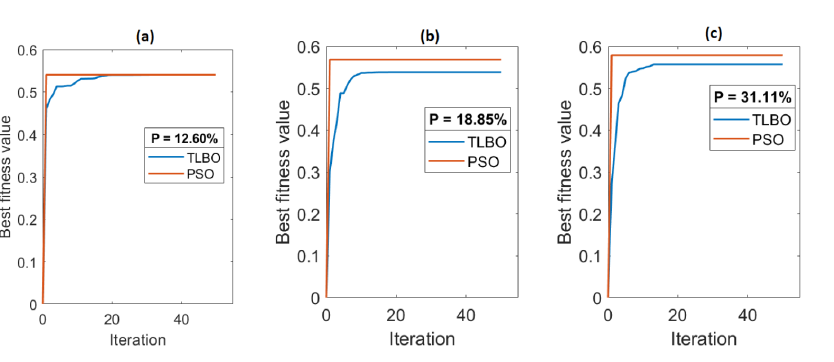
Figure 8. Convergence curves of PSO and TLBO for optimization of MRR and TWR. ( a ) convergence curve or 12.60% PSS, ( b ) convergence curve for 18.85% PSS, ( c ) convergence curve for 31.11% PSS.